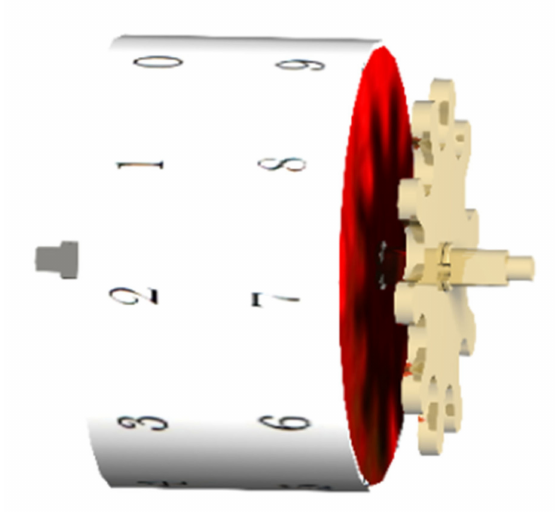
Figure 9. Output sub-assembly.